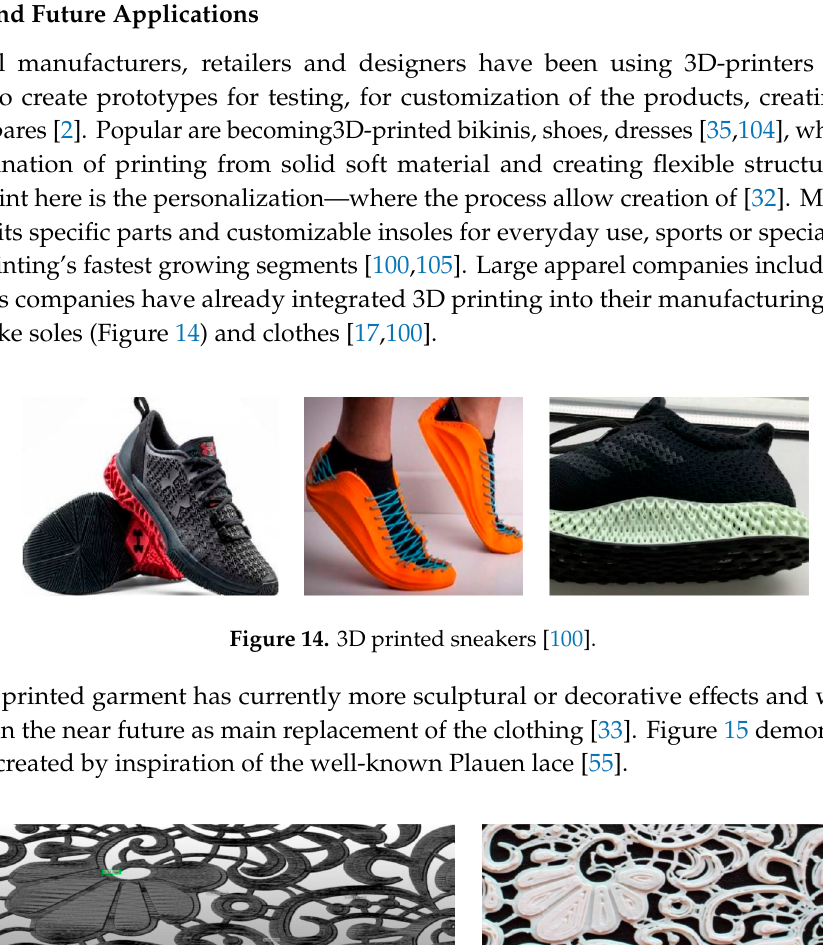
Figure 13. Products manufactured by Electro-Loom (white color products without decorations) [103]